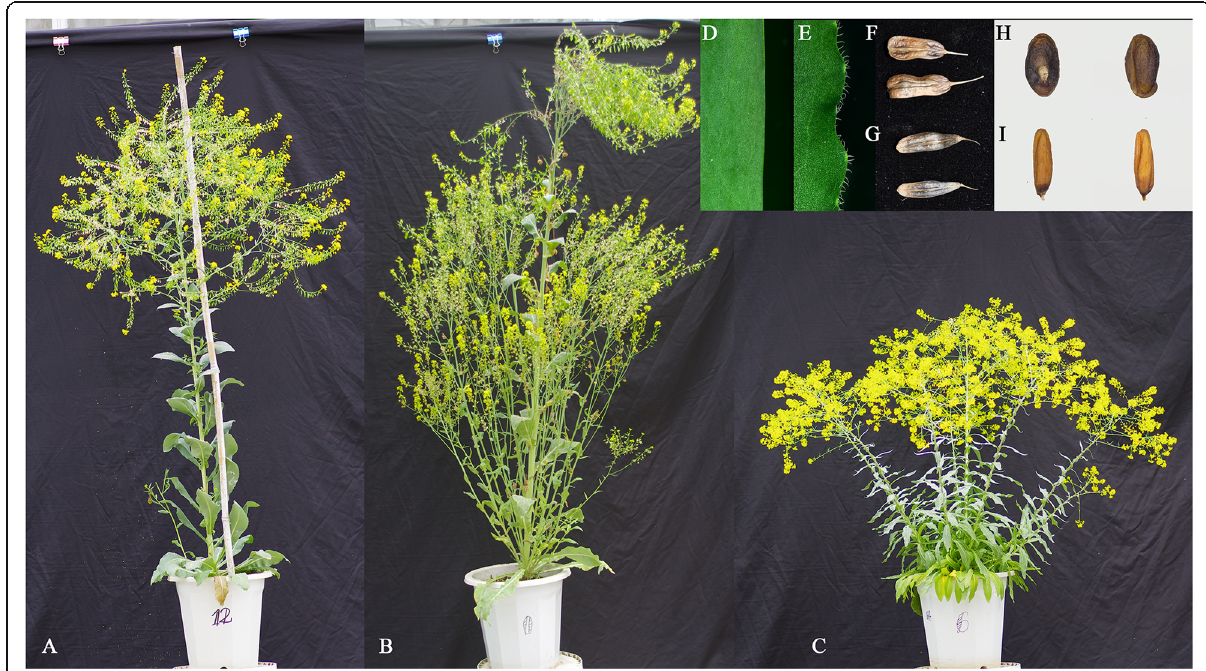
Fig. 1 Morphological differences between I. indigotica and I. tinctoria. A; tetraploid I. indigotica ; B; diploid I. indigotica ; C; I. tinctoria ; D, F, H; the leaf edge, fruits, and seeds of I. indigotica , respectively; E, G, I; the leaf edge, fruits, and seeds of I. tinctoria ,